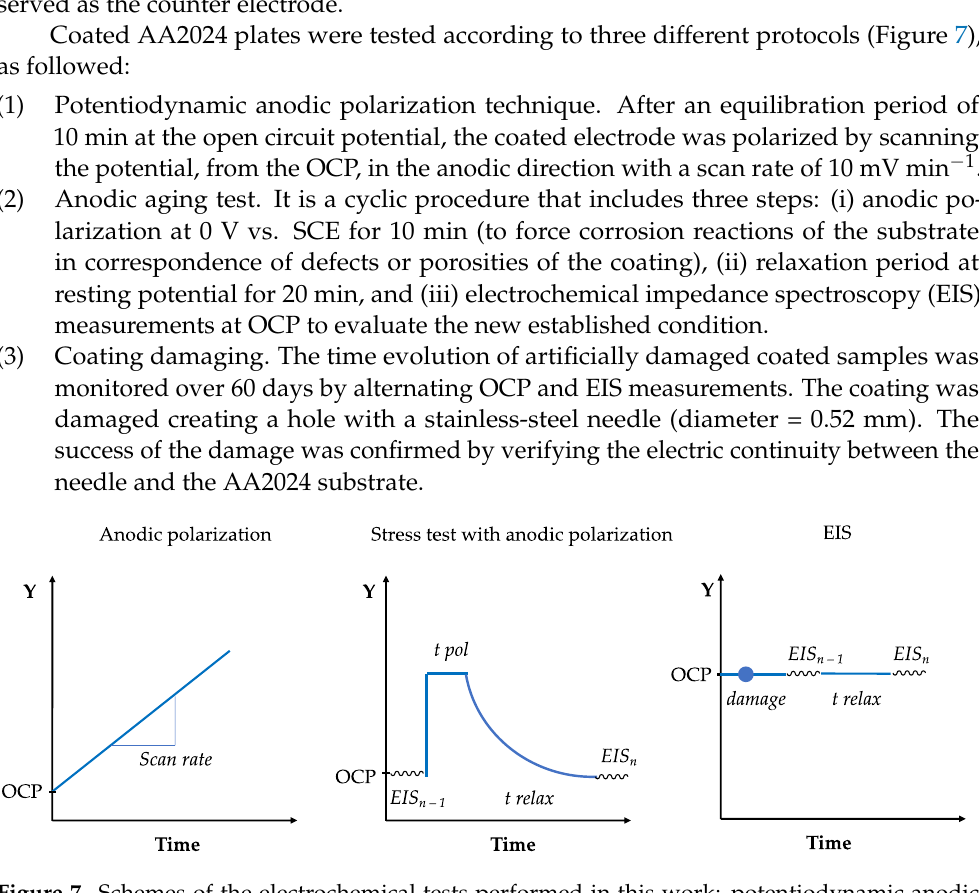
Figure 7. Schemes of the electrochemical tests performed in this work: potentiodynamic anodic polarization ( left ), anodic aging stress test ( middle ), and testing of artificially damaged samples ( right ). Y-axes report the electric potential (vs. the operating reference electrode), OCP is the open circuit potential, t pol is the duration of the anodic polarization, t relax is the relaxation time at the OCP. Damage corresponds to the time when the artificial scratch was done on the coating. Times are not scaled